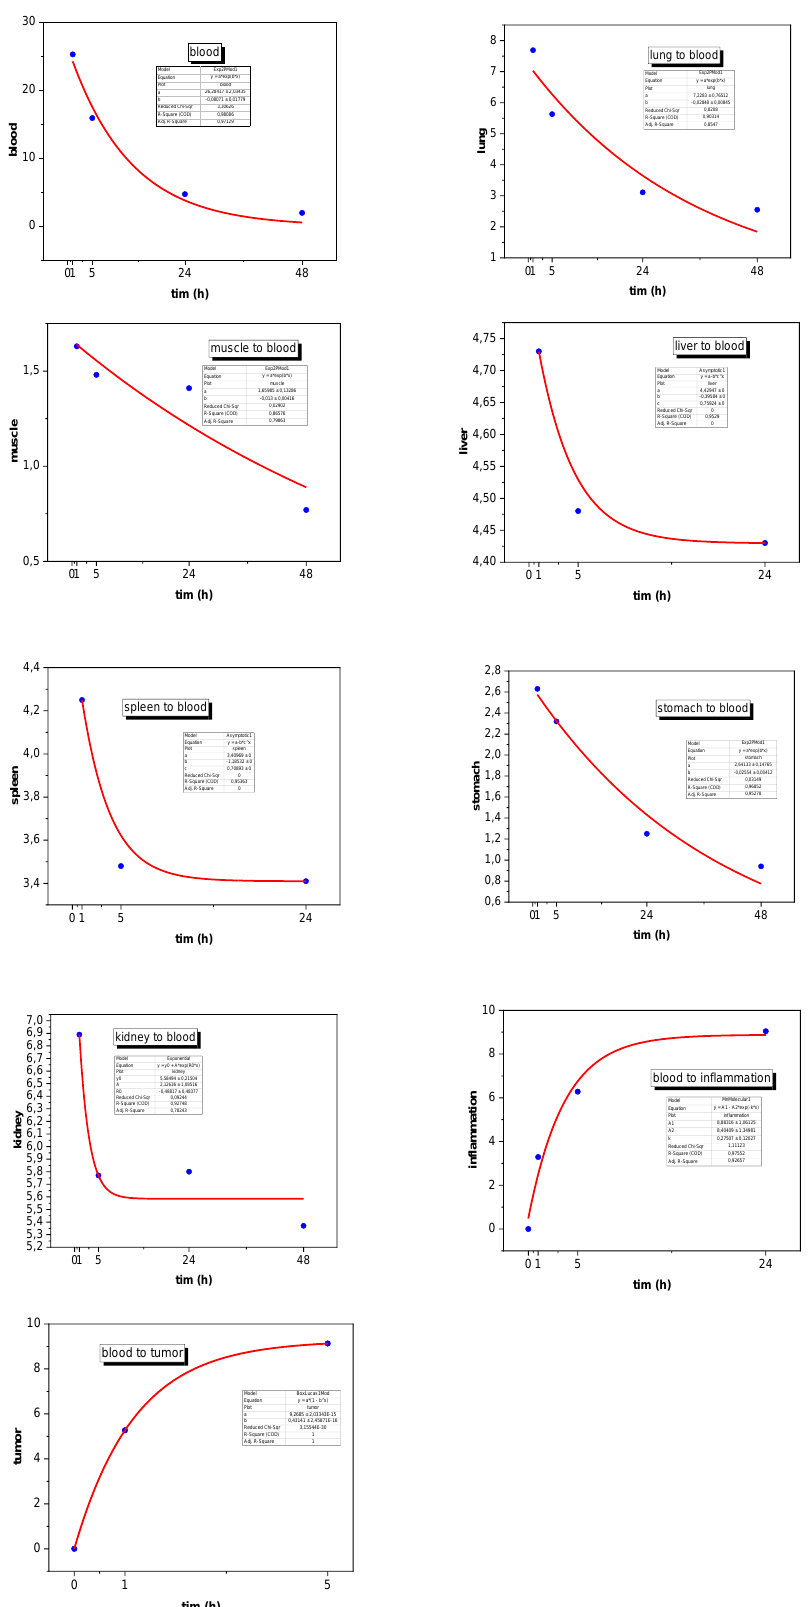
Figure 2. Transfer decay: an exponential function fitting estimated coefficients of transition from the organs to the blood and from the blood to the organs. The distribution of radiopharmaceuticals in the human body can be described using a system of differential equations of the first order. However, solving such a system can be extremely complex, and the number of equations can reach 20 to 40. To overcome this challenge, WinAct software can quickly solve the system of equations [24]. The main pa- rameters required for calculating the radiopharmaceutical distribution are the transition coefficients (day −1 ) from the blood to the organs and vice versa, represented in the dia- grams shown in Figure 3. Figure 3. WinAct Running. When the input file is created, WinAct generates three output files and an infor- mation file with a “.log” extension that duplicates the input data. The file with the “.act” extension contains information about the activity present in an organ or tissue as a func- tion of time since the administration of the radionuclide. This file is used to plot the reten- tion of activity in relation to time after administration. The file with the “.ext” extension